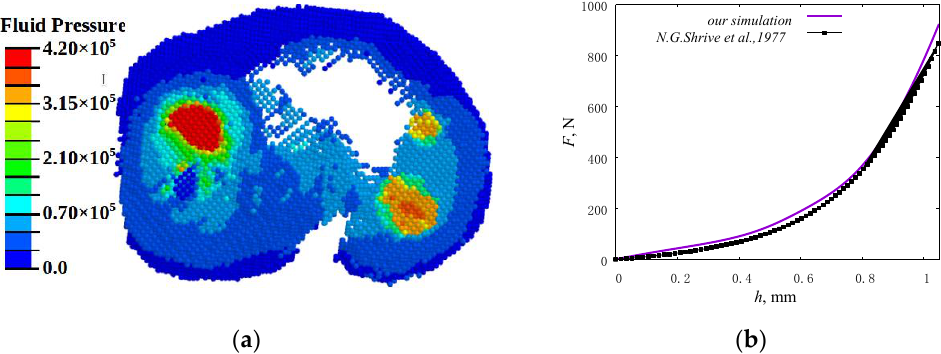
Figure 5. Results of the model validation: ( a ) distributions of fluid pressure (Pa) in the tibia cartilage pores (our simulation); ( b ) plots for applied force versus displacement.